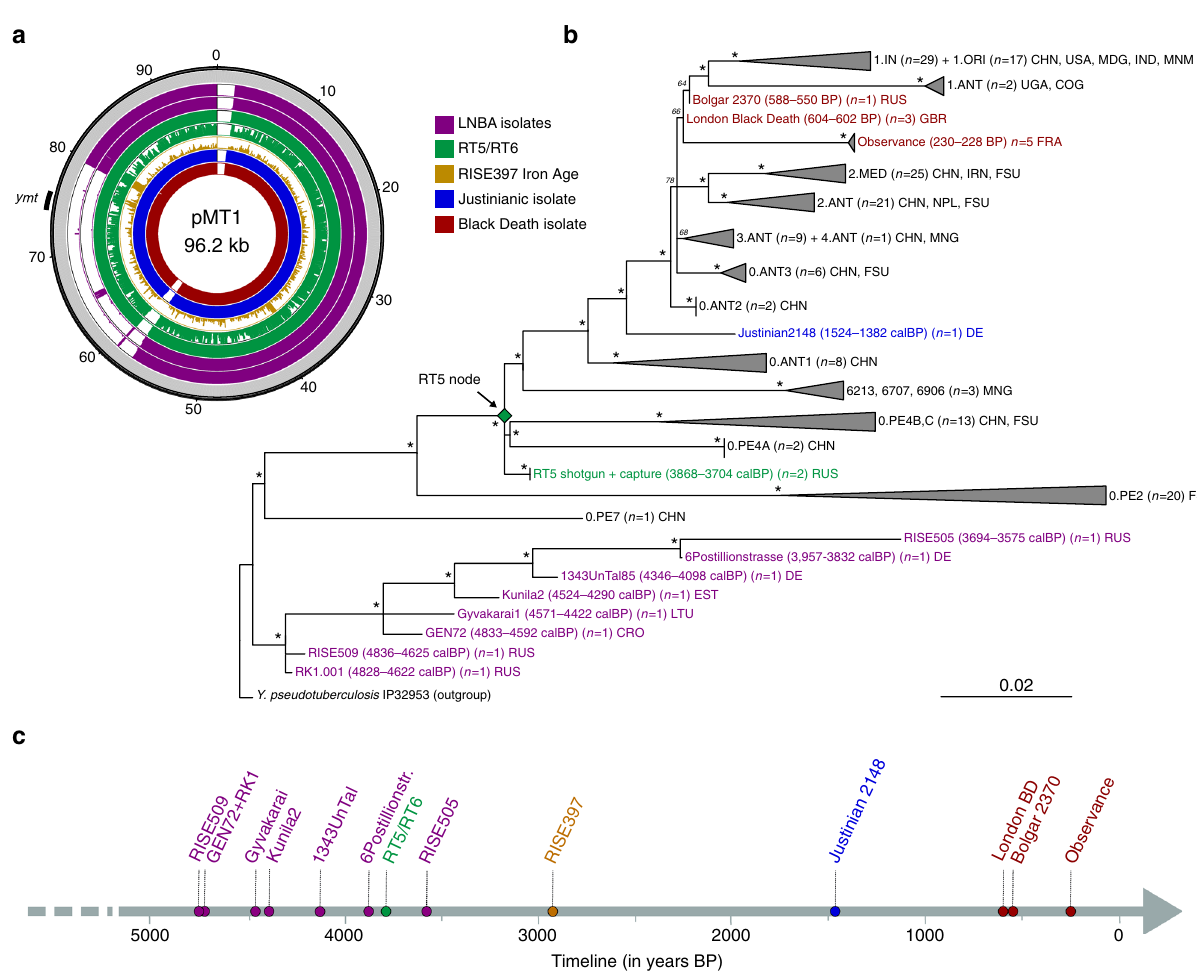
Fig. 2 Y. pestis genomic characterisation and maximum likelihood phylogeny. a pMT1 coverage plots made with the Circos 80 software. The plots were constructed to a maximum coverage of three-fold, and average coverage was calculated over 100-bp windows. The presented strains are in the following order starting from the outmost: CO92 pMT1 (reference) in grey, the oldest (RISE509) and youngest (RISE505) isolates from the LNBA lineage are shown in purple, RT5 and RT6 are shown in green, the Iron Age RISE397 isolate is shown in brown, a Justinianic isolate from Altenerding (Germany) is shown in blue and a London Black Death isolate is shown in red. The position of the ymt gene within the pMT1 plasmid is indicated on the plot. b A worldwide dataset of Y. pestis ancient and present-day chromosomal genomes ( n = 179) was used to reconstruct the phylogenetic tree, considering 1054 SNP positions (see Supplementary Fig. 3 for a phylogeny using all sites). The main branches were collapsed to enhance the clarity of the phylogeny, and branch lengths are shown as number of substitutions per site. The newly sequenced RT5 strain (green) was included in the phylogeny alongside eight Bronze Age strains belonging to the LNBA lineage (purple), a single Justinianic strain (blue), and nine second pandemic strains (red). Asterisks denote bootstrap values >95 (1000 bootstrap iterations carried out). The two-sigma (95.4%) radiocarbon or archaeological dates of Bronze Age and historical strains are shown. Country or geographical region abbreviations are as follows: CHN (China), USA (United States of America), MDG (Madagascar), IND (India), IRN (Iran), MNM (Myanmar), RUS (Russia), GB (Great Britain), DE (Germany), FRA (France), MNG (Mongolia), NPL (Nepal), FSU (Former Soviet Union), CGO (Congo), UGA (Uganda), LTU (Lithuania), EST (Estonia) and CRO (Croatia). See also Supplementary Fig. 4 for the inferred phylogenetic positioning of RISE397. c Timeline spanning radiocarbon and archaeological dates, from which Y. pestis genomic data have been included in this study. Points on